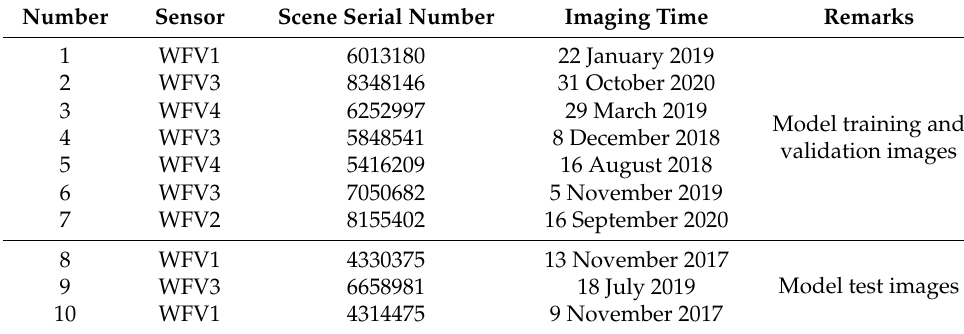
Table 2. List of data used in the